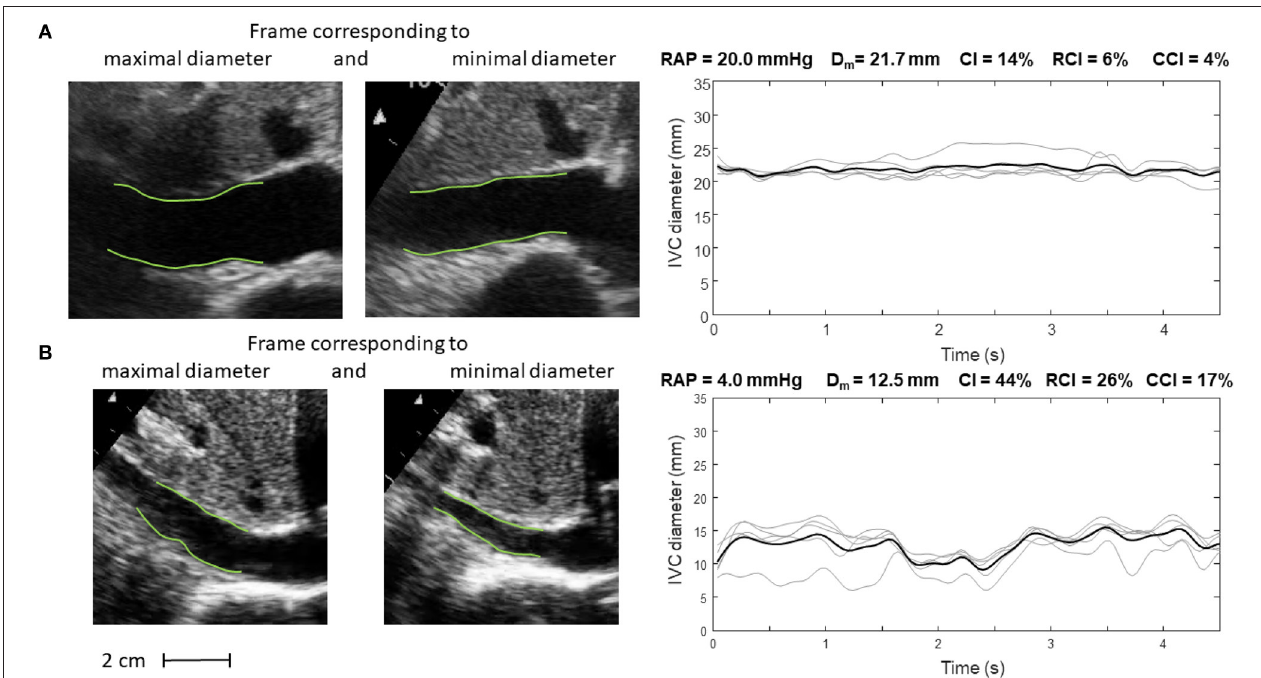
FIGURE 5 | Inferior vena cava (IVC) dynamics in patients with different right atrial pressure (RAP, measured invasively). (A) Patient with high RAP. (B) Patient with low RAP. Abbreviations used: average diameter D m , caval index CI , respiratory caval index RCI , cardiac caval index CCI